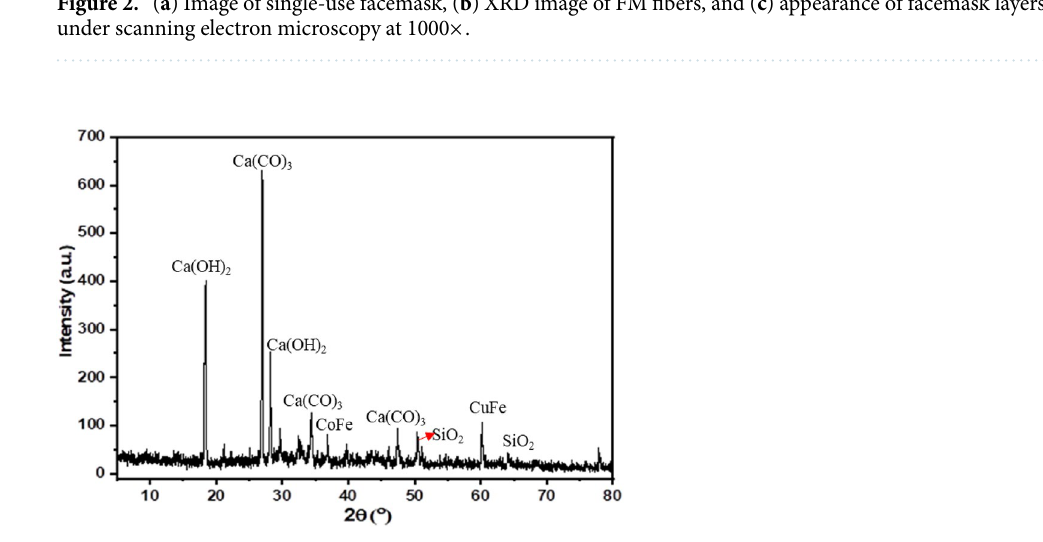
Figure 3. XRD analysis of concrete with 2% HPPM after 28